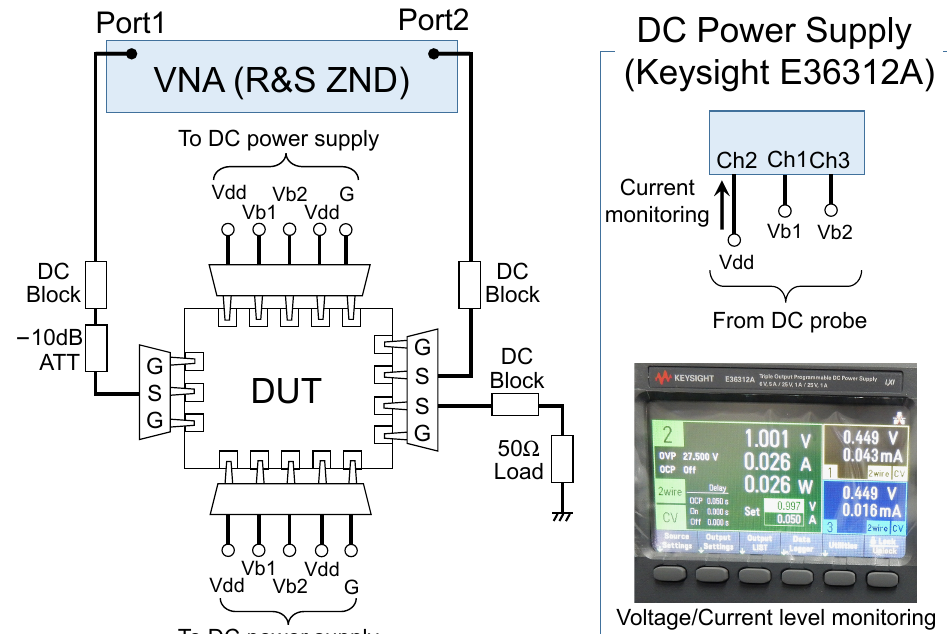
Figure A1. Test setup for S-parameter measurement.